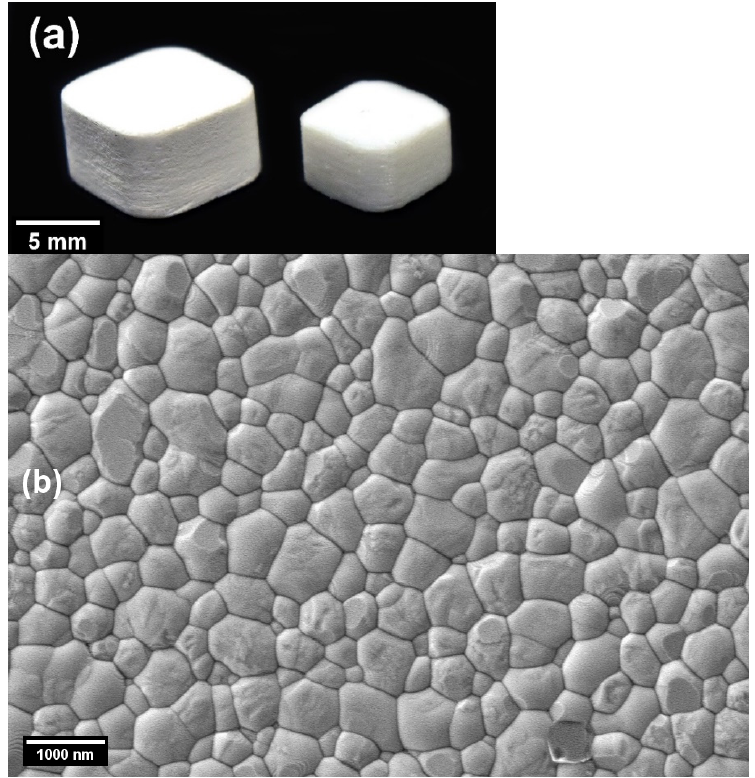
Figure 9. ( a ) As-printed and sintered samples for reference; ( b ) microstructure of the polished cross-section of 45 vol.% solid loaded zirconia at 30,000 ×